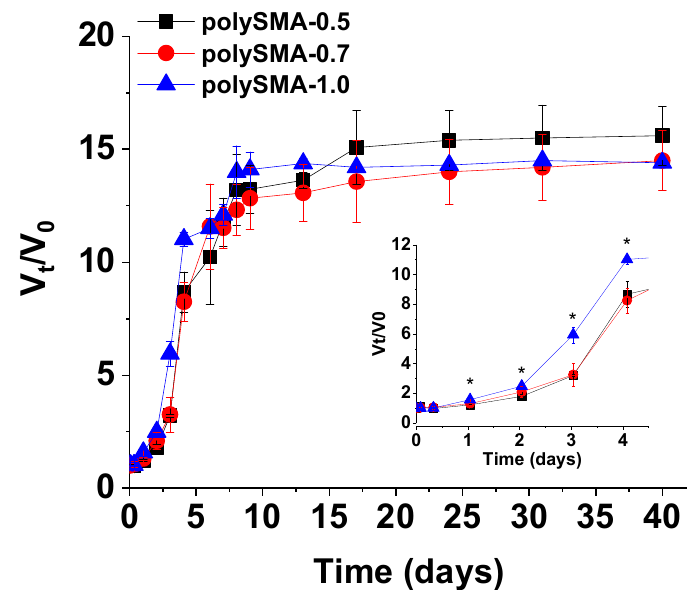
Figure 2. The time-dependence of swelling volume ratio ( V t / V 0 ) in PBS solution (pH 7.4) of the polySMA hydrogels prepared with different crosslinker content. Error bars were calculated using standard deviation ( n = 3). The values with * represent the significant difference between the swelling ratios of individual hydrogels with P < 0.05.